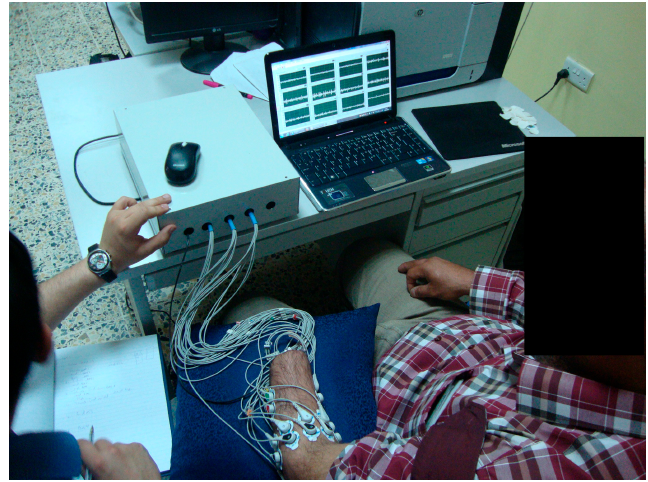
Figure 3. Picture showing the protocol used in this study where amputee TR5 is using the intact-hand to help him imagine the fine pinch movement with his stump.